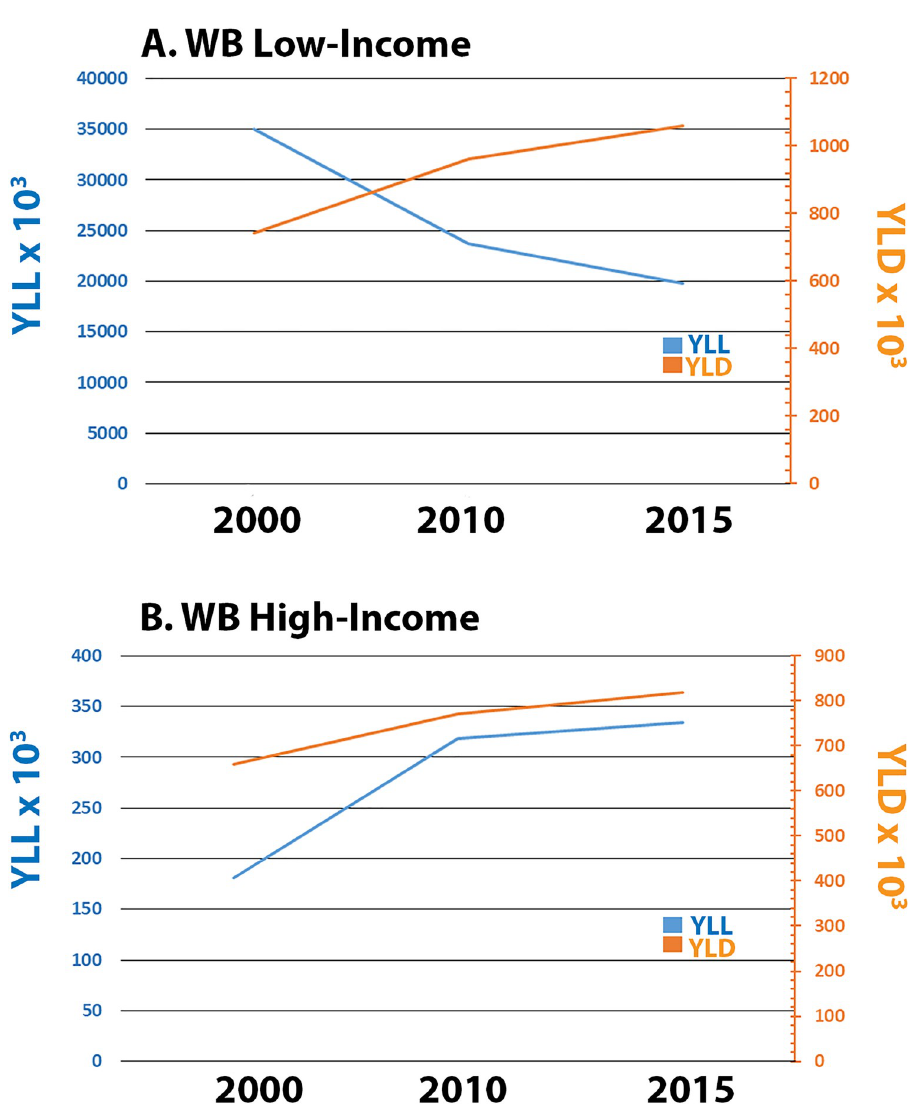
Fig 3. Years-of-life-lost (YLL) and years-lived-with-disability (YLD) due to DD. YLL and YLD data are available from GBD2017 for the years 2000, 2010 and 2015. DD YLLs (x 10 3 ) and YLDs (x 10 3 ) for WB low-income (A) and WB high-income (B) countries by year are